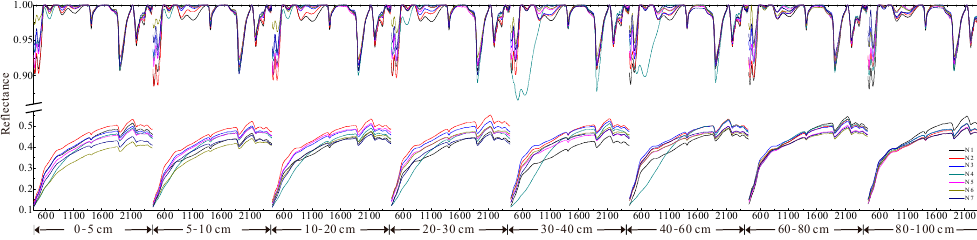
Figure 4. Pseudo multi-depth curves of smoothed and continuum-removed spectra for partial profiles. The pseudo multi-depth curve was created by joining the spectra from the eight depth intervals of a profile in sequence, which represents the spectra of the whole profile from topsoil to bottom soil.